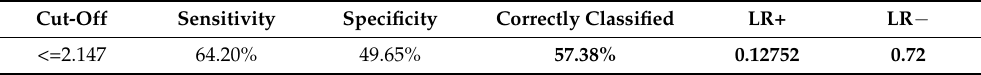
Table 5. The cut-off with the highest specificity and sensitivity calculated by the Youden Index. Cut-Off